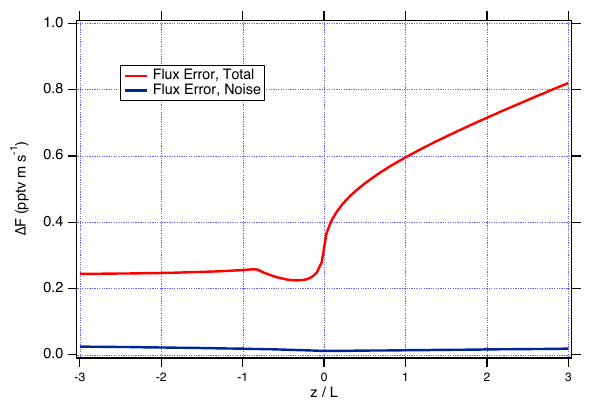
Fig. 8. Computed absolute flux error as a function of atmo- spheric stability ( z /L). Error is computed from Eqs. (23)–(27) for the following conditions: z =18m, u r =8ms − 1 , u ∗ =0.28ms − 1 , F 0 =1pptvms − 1 (3.6µmolesm − 2 d − 1 ), and φ c The contribution of noise from the second term in Eq. (23) is small and relatively constant as a function of